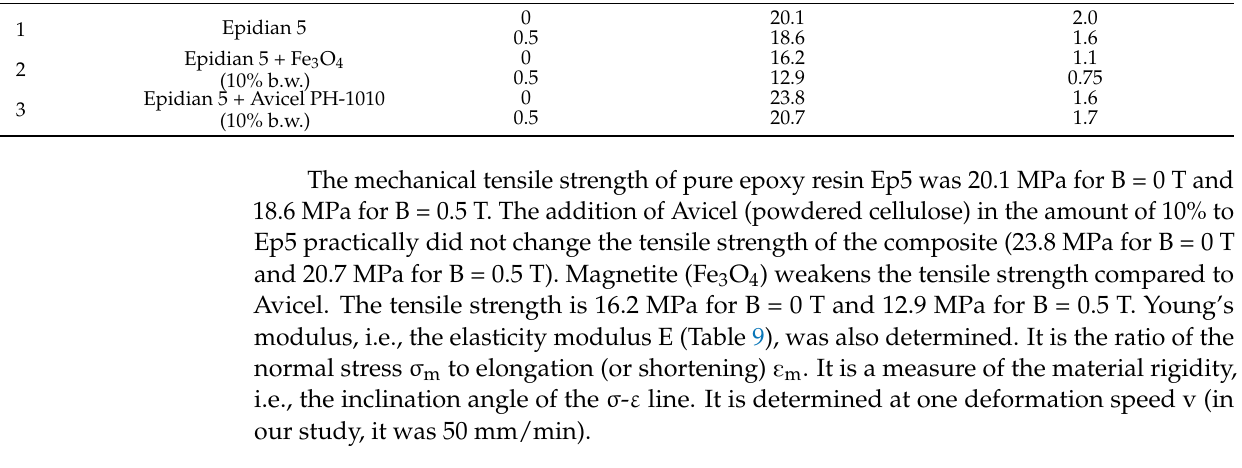
Table 9. Determination of Young’s modulus for selected